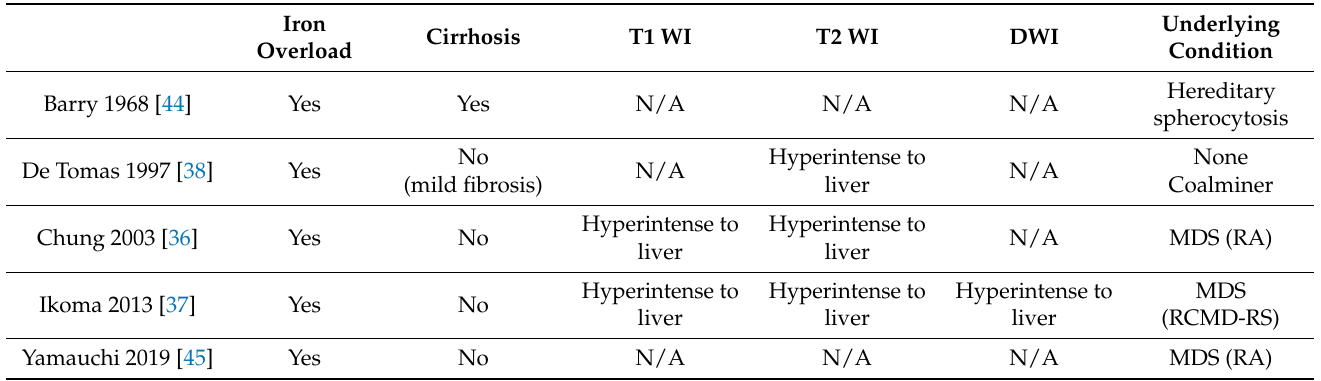
Table 1. HCC in secondary hemochromatosis: review of the literature.